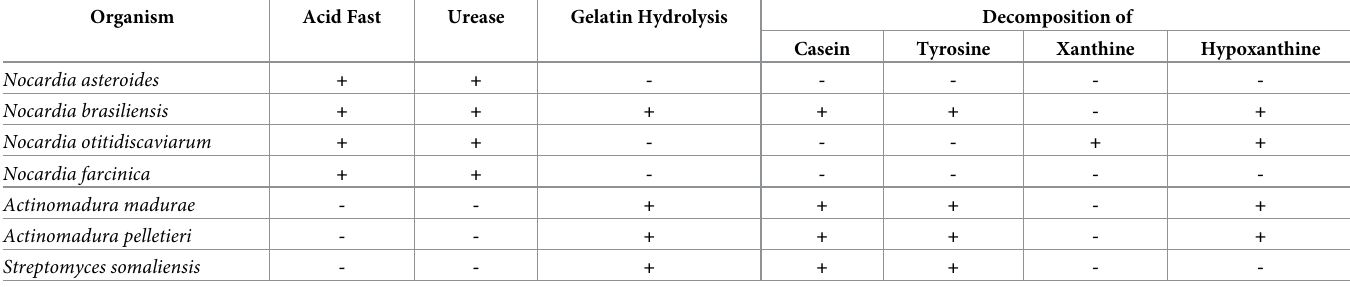
Table 3. Different Biochemical test that used in discrimination between the actinomycetoma causatives agent.